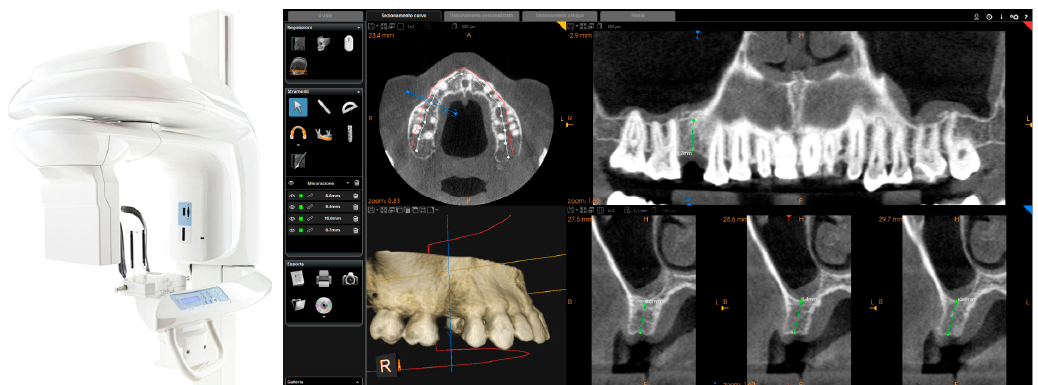
Figure 2. CBCT with CS 9300 ® (Carestream Dental, Atlanta, GA, USA). The first visualization of the CBCT reveals sufficient bone volume (height and width) to plan the position of a dental implant.